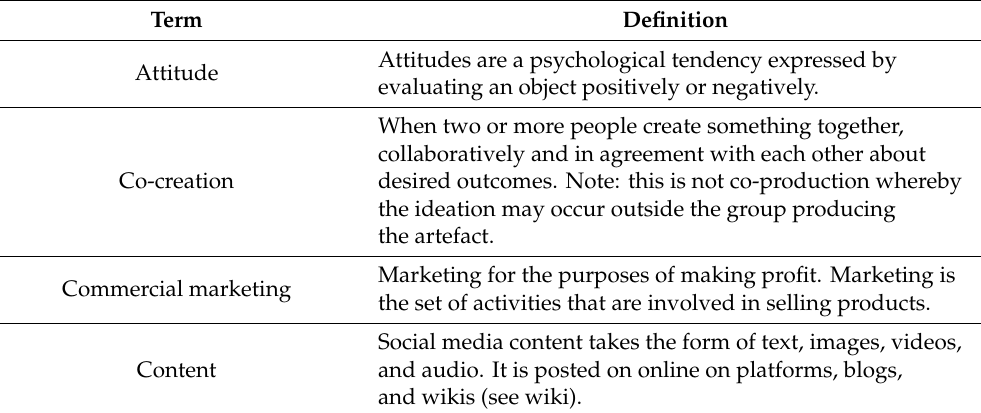
Table A1. Glossary of